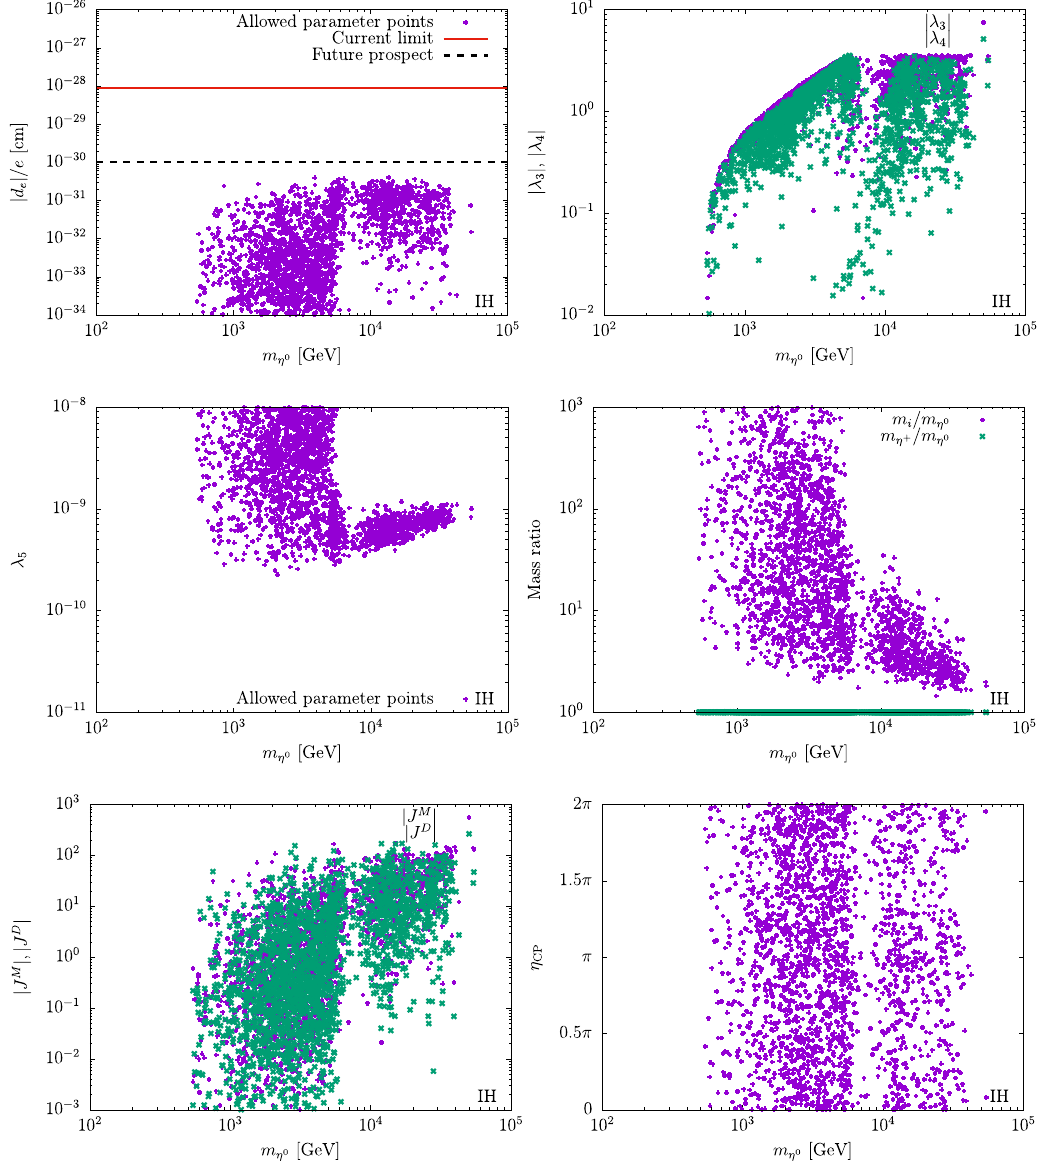
Figure 7 . Numerical results for scalar dark matter in the case of inverted hierarchy for the light neutrino mass spectrum. Each point complies with all the constraints discussed in section